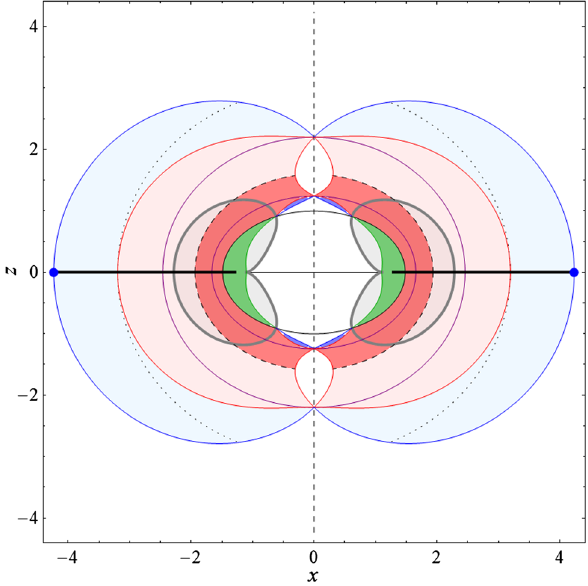
r (cid:4)φ = 0 < r < r pol + there appear globally retrograde Fig. 17 Structure of the SPOs in the KNS spacetime with a = 1 . 1 orbits. The other properties remain the same as in pre- corresponding to the Class III vious case and the SPOs structure is represented by the Fig. 17. from the globally retrograde ones is at r < r (cid:4)φ = 0 ( max ) (black Class V : KNS spacetimes with 1 . 17996 = a pol ( max ) ≤ dot-dashed curve in Fig. 18 below) and it slowly decreases a < 3 . For a = a pol ( max ) , the two polar SPOs coalesce √ as a → ∞ (see Fig. 7). In addition to this, the discussion is 3 (see Fig. 18 above). at r = r pol = qualitatively same as in the previous case. Class VI : Kerr naked singularity spacetimes with a ≥ 3 . For a = 3 the local extrema of the function q sph ( r ; a ) coalesce at the inflex point at r = 3 = r ms + with q inf